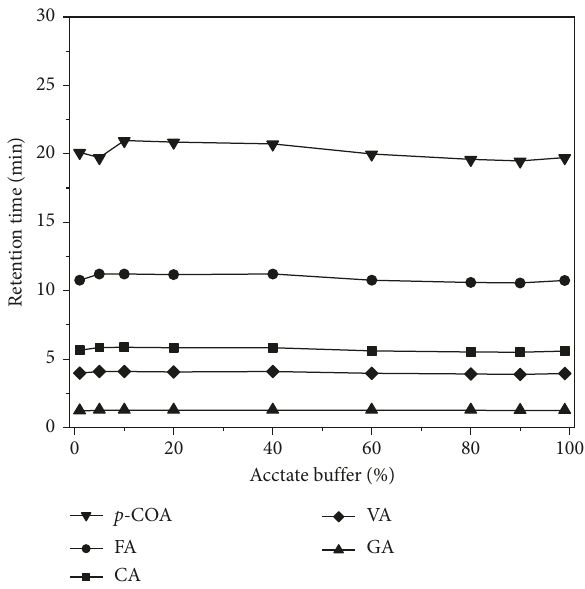
1 acetate buffer (pH 5.0) concen- Figure 4: Effect of 0.20mol L · tration on the retention times of a mixture of polyphenols. CA: − caffeic acid (3.60 mg L · − 1 ). Conditions: isocratic elution with 1 acetate buffer : ultrapure water as mobile phase; flow 0.20mol L · 1 ; detection potential of 0.80V (versus rate of 0.8mL min − · −